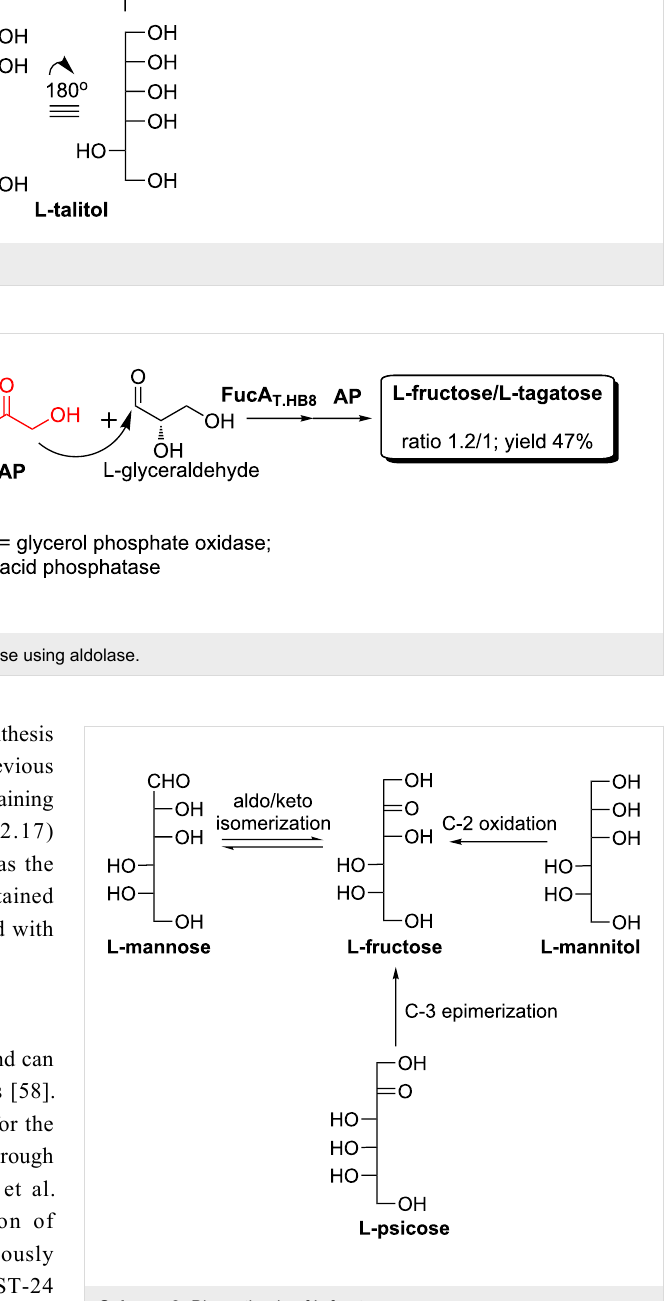
Scheme 8: Biosynthesis of